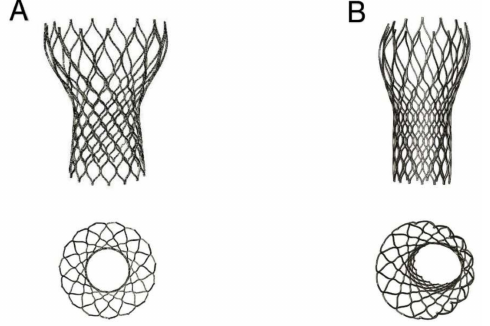
Figure 8. ( A , top and bottom) Ideal CoreValve expansion with stent shape implantation; ( B , top and bottom) Real deformation of the stent shape after implantation in the investigated patient’s root. Top: not complete expansion of the device; Bottom: asymmetric stent